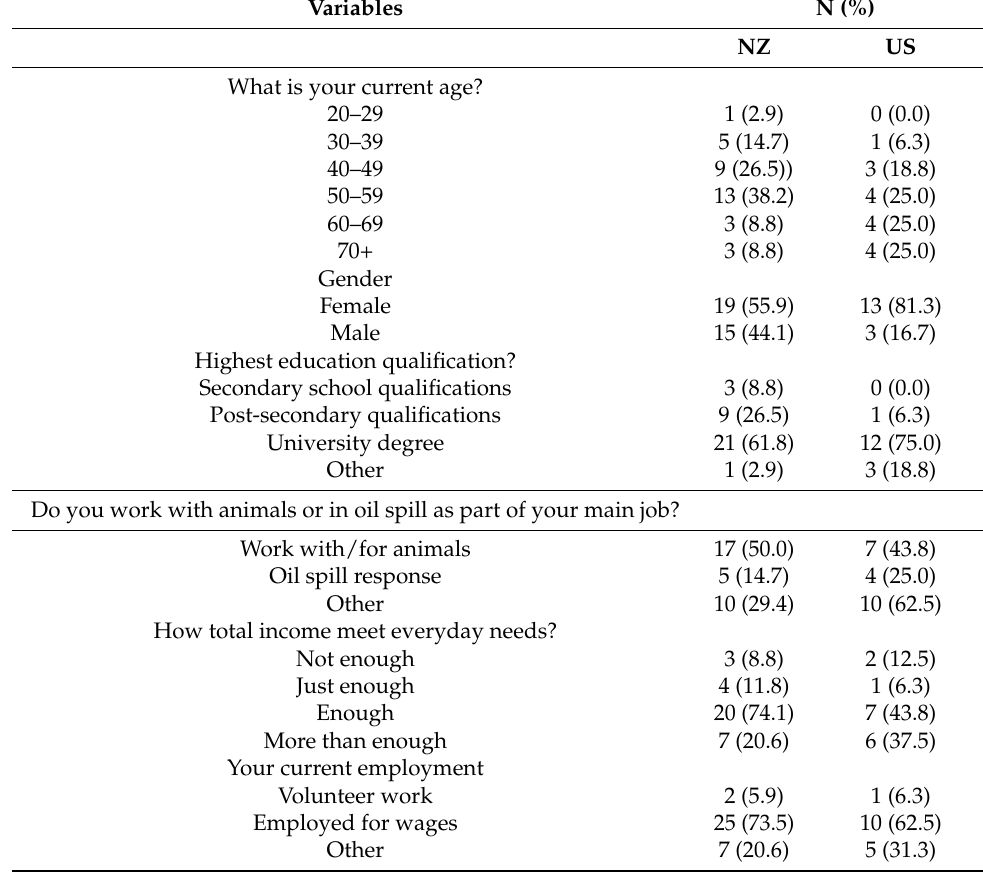
Table 1. Oil spill respondents background and demographic